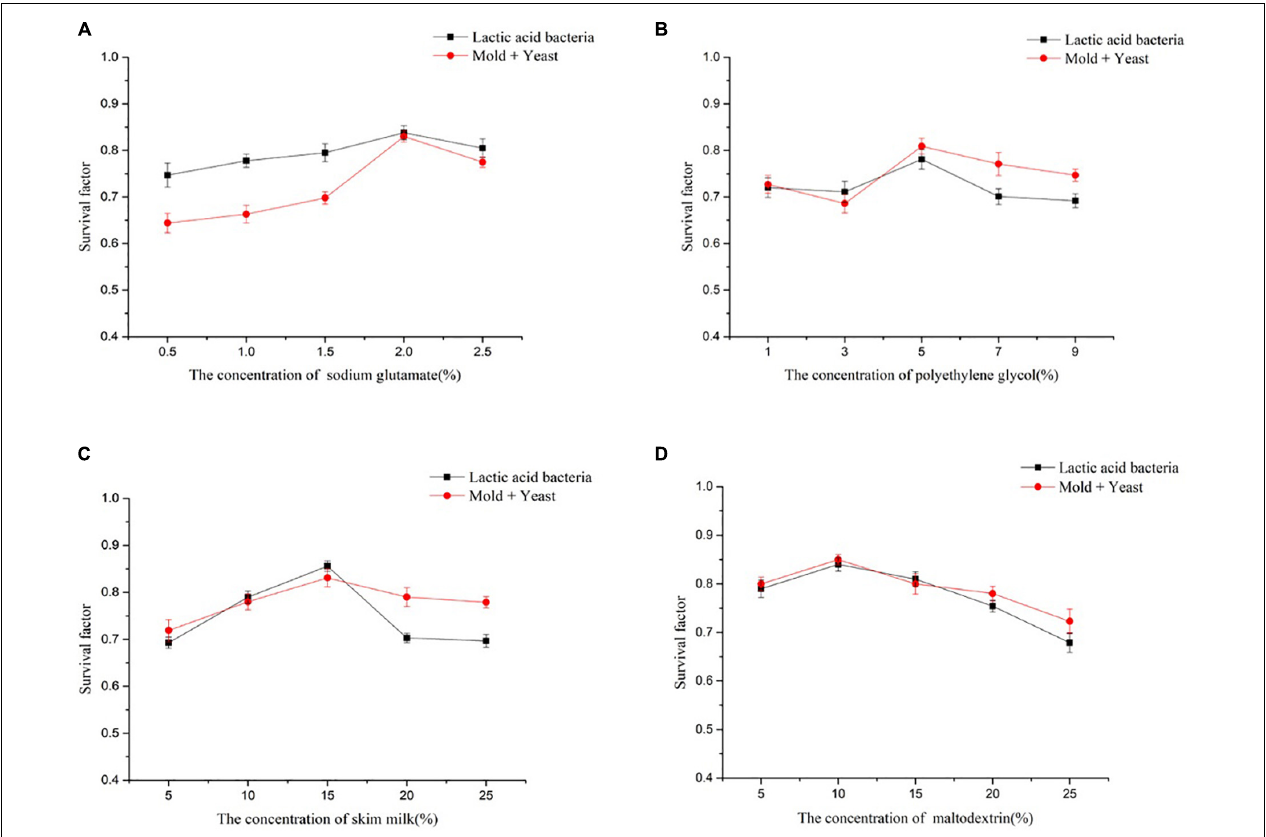
FIGURE 1 | Effects of different concentrations of four lyoprotectants on the survival factor of the artificial starter culture. (A) Sodium glutamate, (B) polyethylene glycol, (C) skim milk, and (D) maltodextrin.